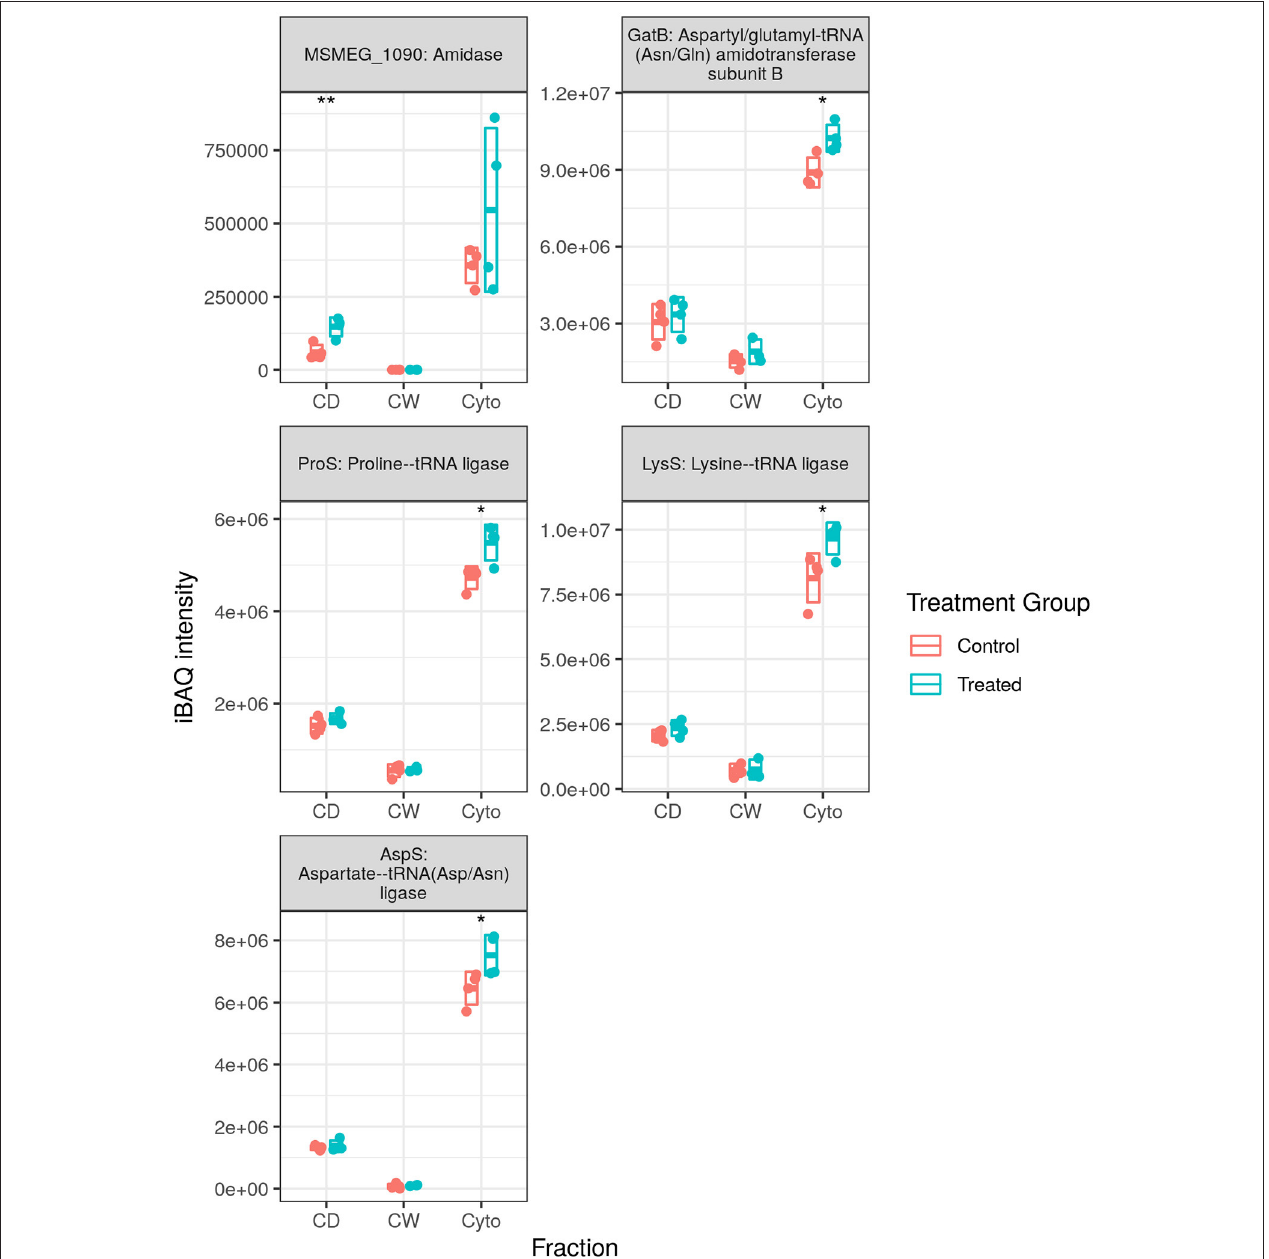
FIGURE 6 | Expression profiles for transfer RNA (tRNA) synthesis enzymes. The trend of generally increased aminoacyl-tRNA synthesis enzyme abundance was conserved in SL samples, albeit with fewer enzymes than that observed in wild-type (WT) samples. Points indicate individual replicate values measured, bars indicate mean expression with error bars indicating SD. Control samples shown in blue and rifampicin treated in red. * and ** indicate p < 0.05 and p < 0.01